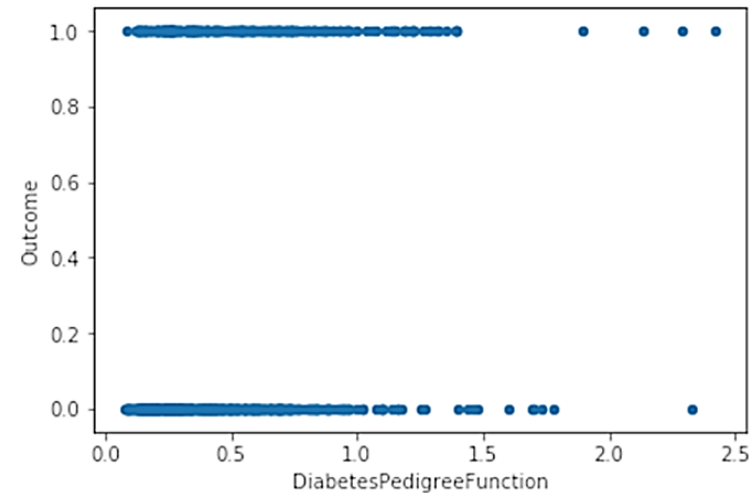
Figure 3. Outcome versus DiabetesPedigree function.